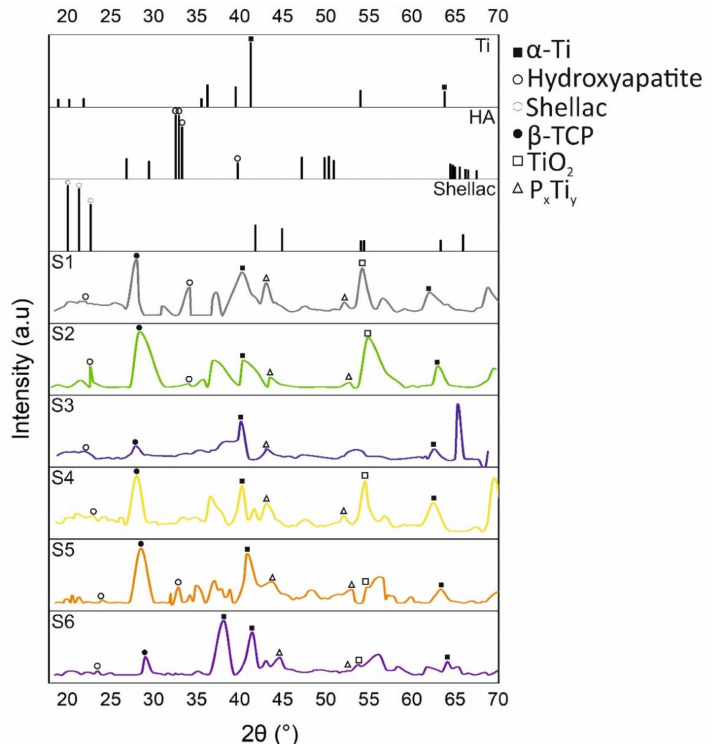
Figure 2. XRD patterns of the initial materials (titanium; hydroxyapatite; shellac) and the Ti-HA composites